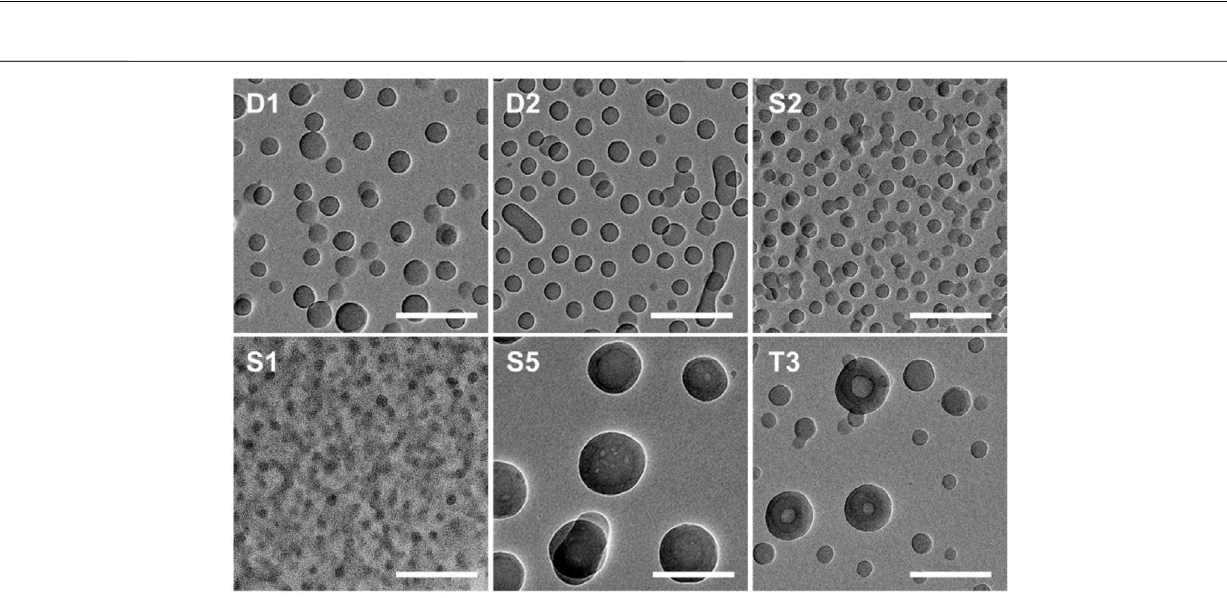
Frontiers in Chemistry |